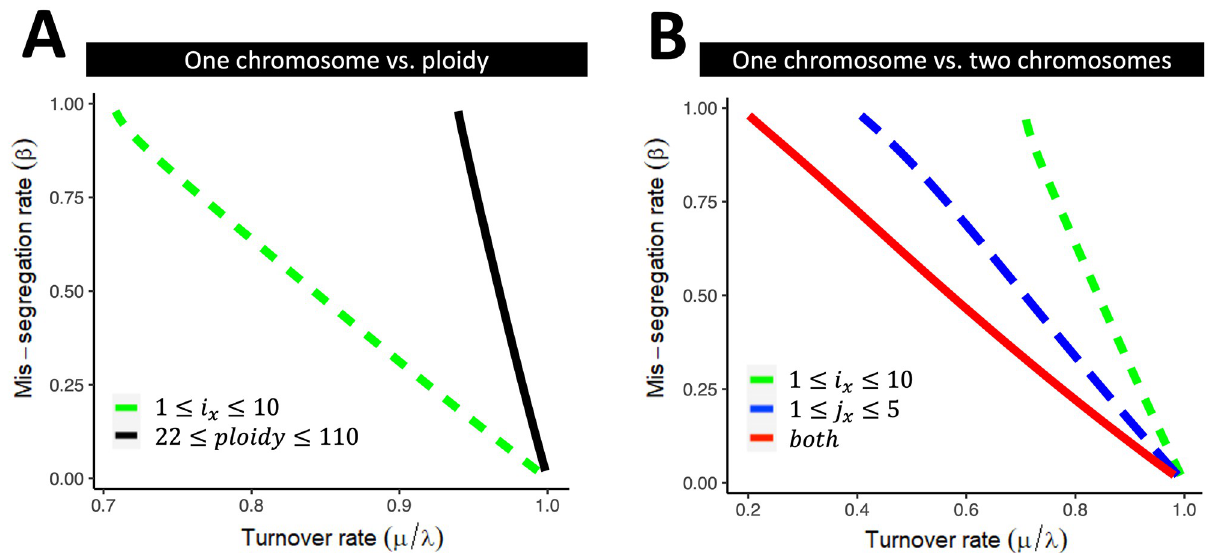
Fig 2. Predicting MIE as a function of homogeneous missegregation and turnover rates. (A-B) Critical curves were obtained by finding ( b ; m which the maximum eigenvalues of the Jacobian (Eq (10)) is 0. (A) We consider two types of viable karyotype intervals with different biological interpretations: intervals modeling the copy number of a single individual chromosome (dashed line) and intervals modeling the ploidy of a cell (solid line). (B) We assume existence of two critical chromosomes i and j , with intervals of viable karyotypes [ k critical curves assuming cell viability is restricted by only one of the two chromosomes (dashed lines), or by both chromosomes jointly (solid line). Note that the size of the Jaccobian is a function of 1 + K − k